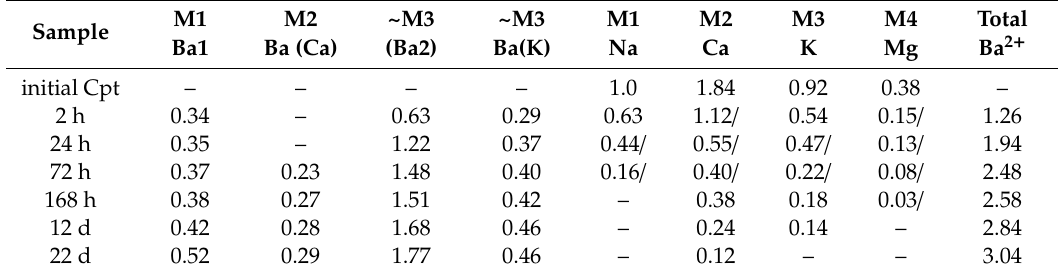
Table 7. Number of atoms per unit cell in the cationic positions of initial and Ba-exchanged clinoptilolite (Cpt) at 90 °C (after structural refinement).